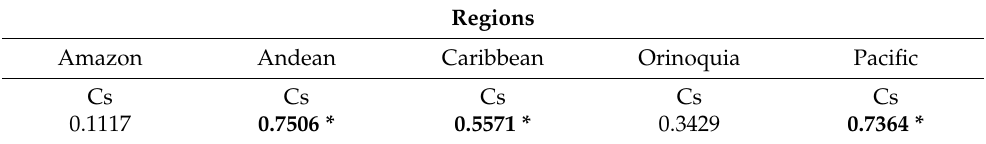
Table 1. Spearman correlation (Cs) between fire density and temperature in the main fire hotspots. Regions Amazon Andean Caribbean Orinoquia Pacific Cs Cs Cs Cs Cs 0.1117 0.7506